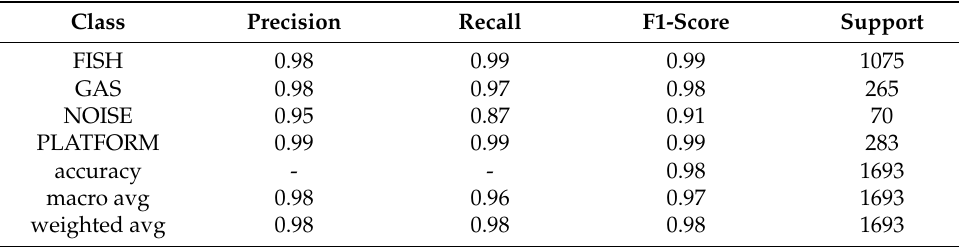
Table 4. Classification report for the ensemble